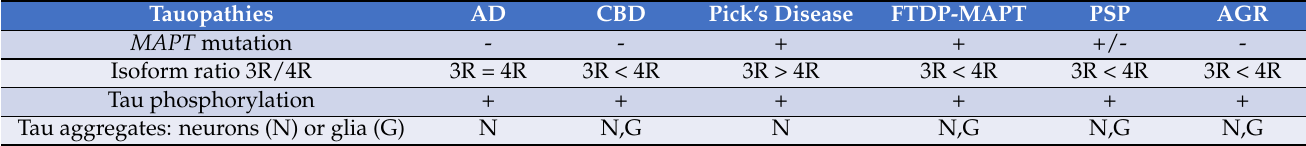
Table 1. Molecular pathological classification of